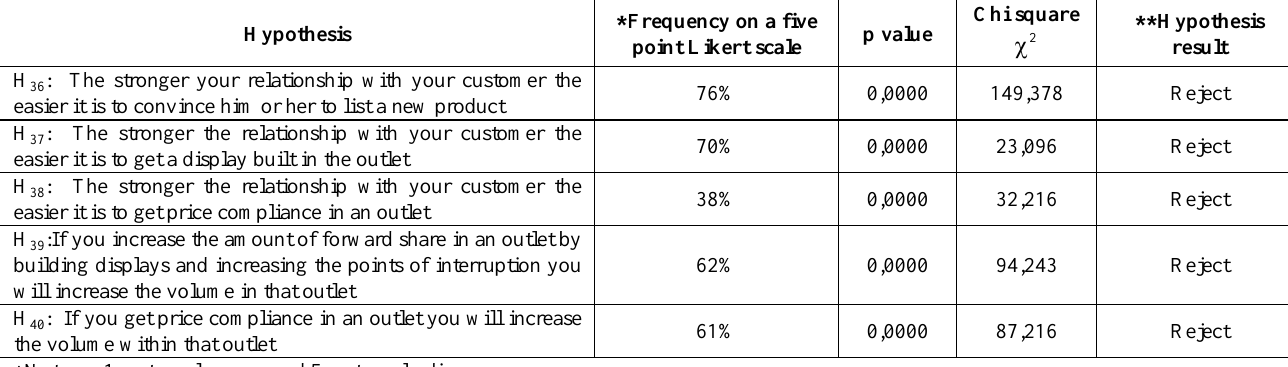
Table 2: Impact of relationship